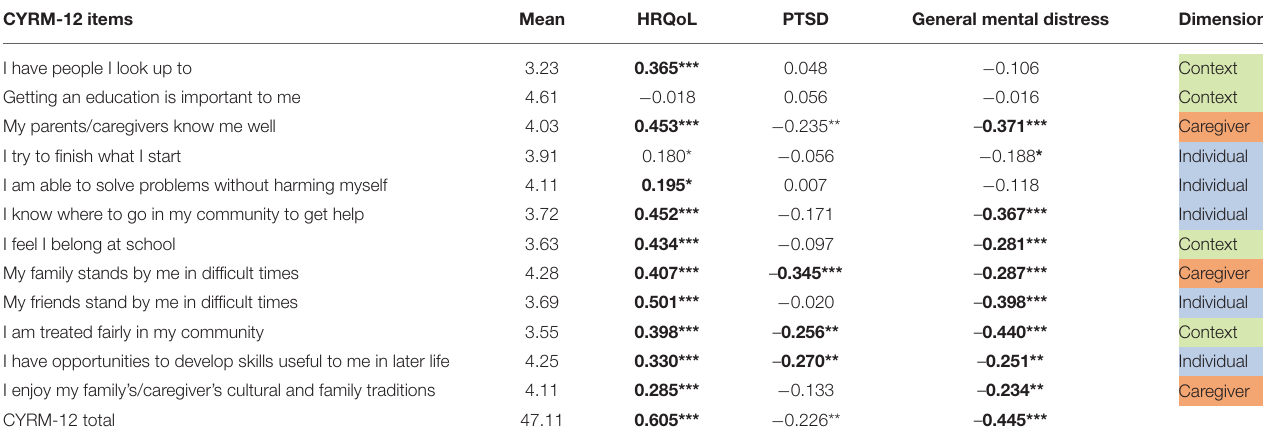
TABLE 5 | Correlations between items in CYRM-12 and HRQoL, PTSD, and general mental distress. CYRM-12